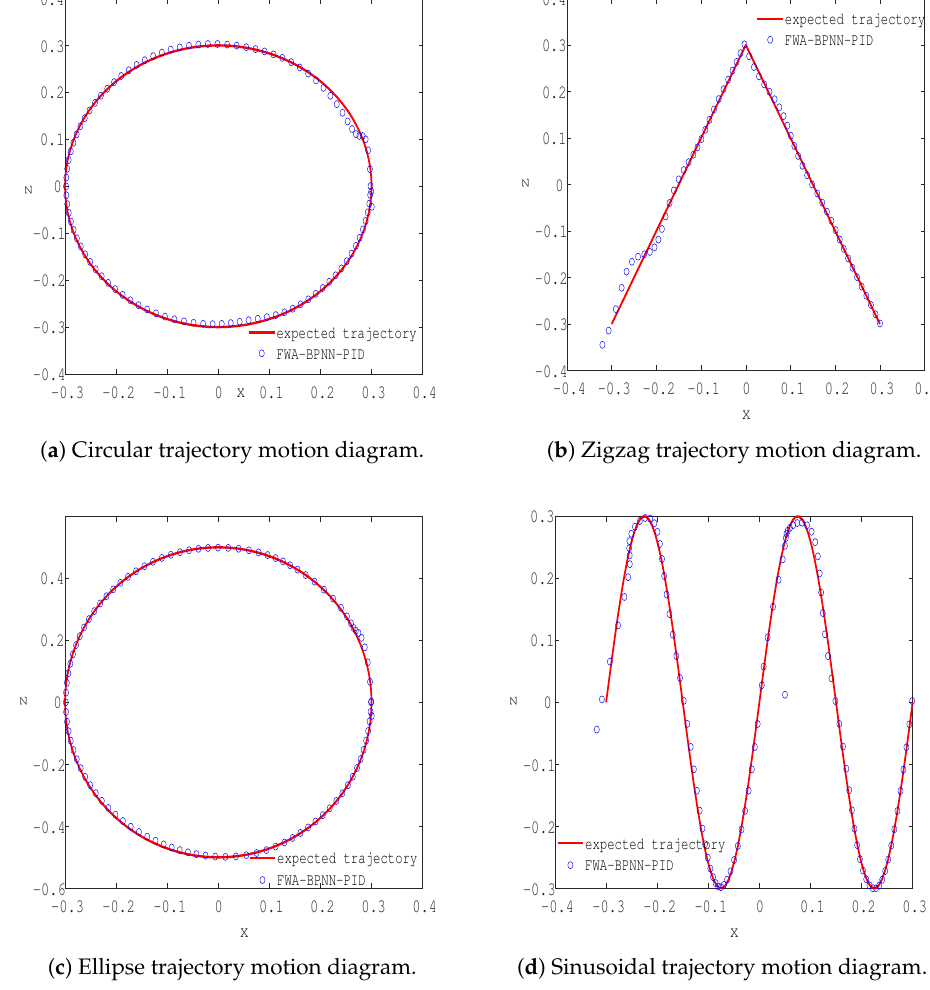
Figure 9. Partial trajectory motion diagram of snake arm in the